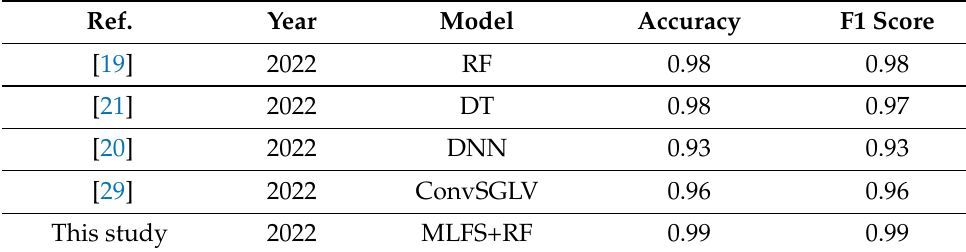
Table 18. Comparison with other